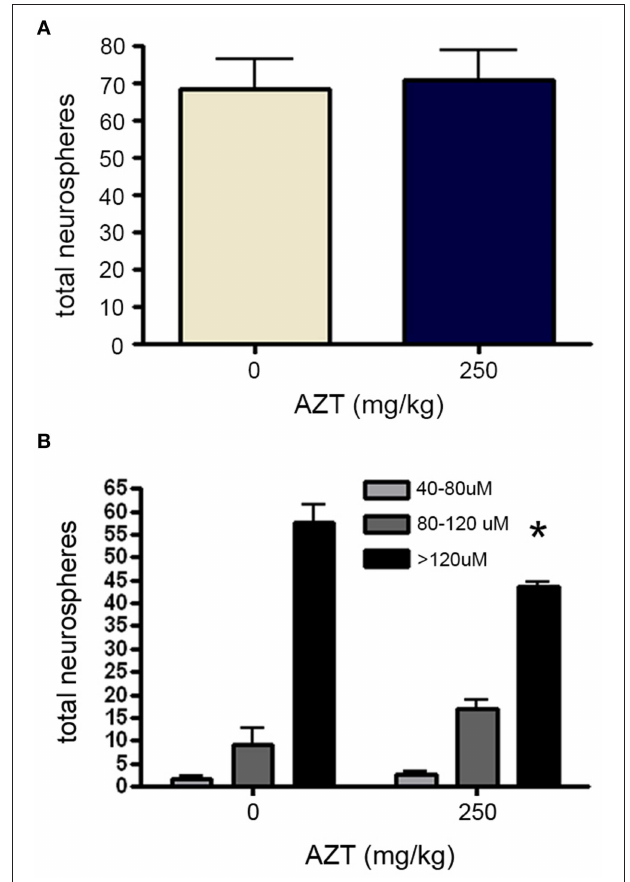
FIGURE 9 | In utero AZT reduces neurosphere size. AZT was administered to pregnant dams from day 12 of gestation until postnatal day 3 (250mg/kg/day, s.q.). Single-cell dissociates of SEZ were prepared from pup brains on postnatal day 3 and assayed for neurosphere production. (A) The total number of neurospheres generated from AZT-treated vs.control pups does not differ. (B) While total neuroshere number does not difffer between treated and control groups, In utero AZT causes a clear and significant reduction in the diameter of neurospheres generated from the pups of treated mothers as compared to the pups of untreated control mothers; notice the reduction in the the number of large diameter neurospheres ( > 120 µ M) and a corresponding increase in the number of small and medium diameter neurospheres (40–120 µ M) in the the treated group as compared to the controls. Unpaired Student’s t -test for (A) ; One-Way ANOVA for (B) N = 3 for all groups; ∗ p < 0 . 05 . Error bars represent standard deviation.